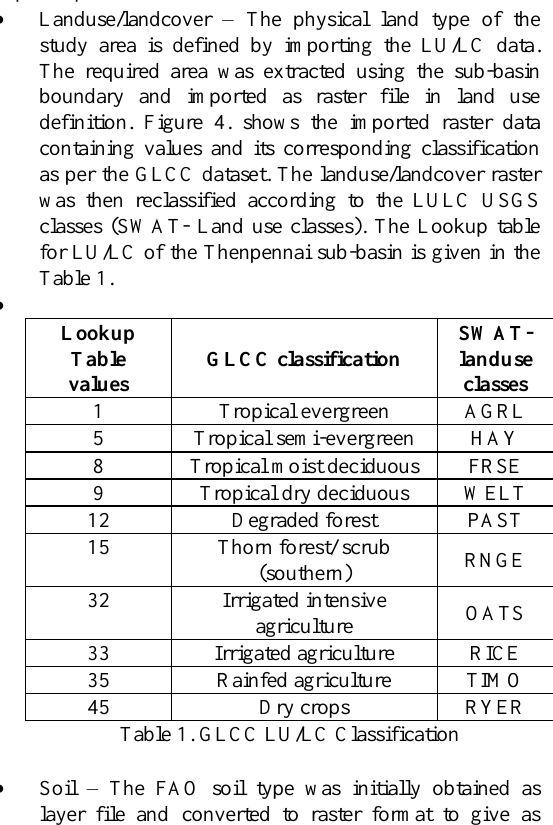
Figure 3. Workflow of SWAT